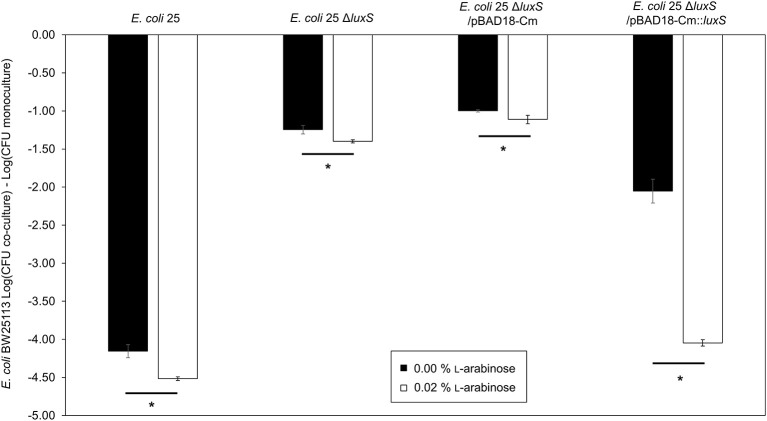
Complementation restores of luxS mccPDI phenotype. CFU counts for E. coli BW25113 following competition with microcin-PDI producer E. coli 25, E. coli 25 ΔluxS, E. coli 25 ΔluxS/pBAD18-Cm, and E. coli 25 ΔluxS/pBAD18-Cm::luxS. Non-induced (black bar) and induced with 0.02% L-arabinose (white bar). Results are expressed as the difference in CFU counts of BW25113 grown in co-culture and monoculture (n = 3 independent replicates; error bar = SEM). *P < 0.05 compared to wild-type co-culture based on one-way ANOVA.